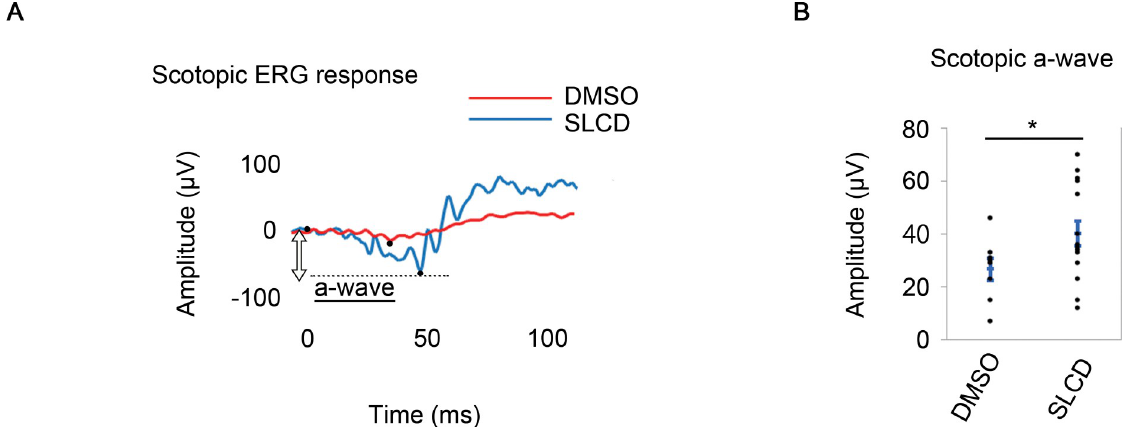
Fig 6. Improvement of the retinal function by intravitreal injection of SLCD in rd10 mice. A) Scotopic response of the ERGs on day 7 after the intravitreal injection of SLCD in rd10 mice. ERG waveform for the SLCD-stimulated group is shown in blue, and that for the control group is shown in red. B) Quantitative results of the a-wave in A). All data are presented as the mean ± SEM (DMSO, n = 8; SLCD, n = 14). � p < 0.05, as per Wilcoxon rank sum